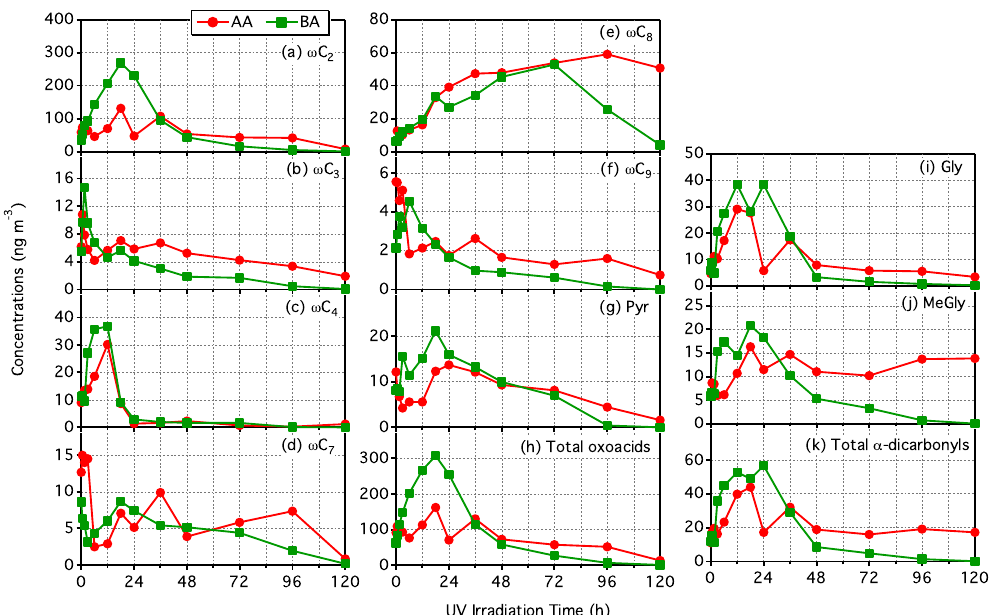
Figure 4. Changes in concentrations of individual oxoacids and α -dicarbonyls and total oxoacids and α -dicarbonyls as a function of UV irradiation time in AA and BA.